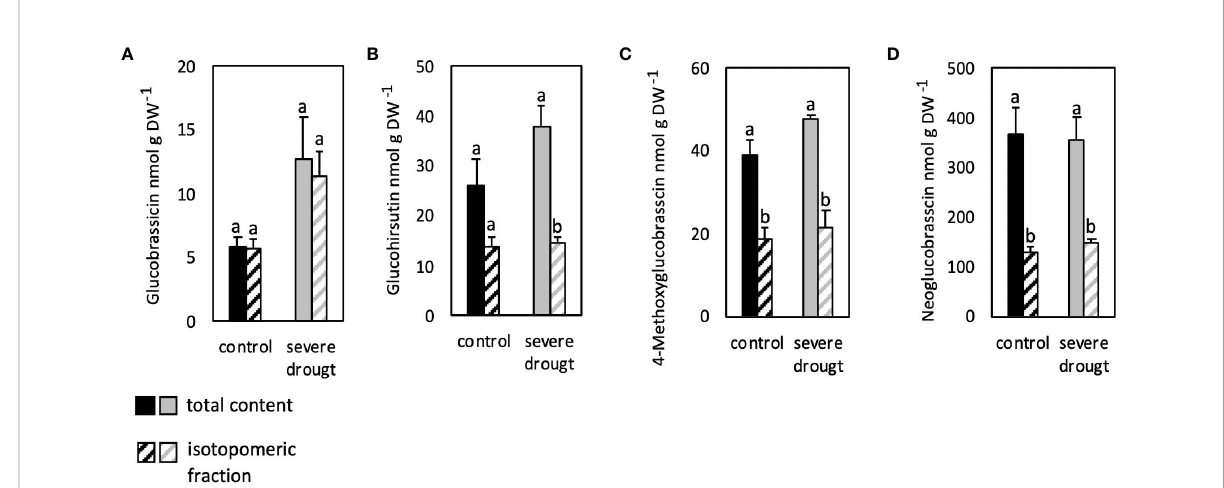
FIGURE 4 Isotopomeric and total contents of aliphatic (B) and indolic glucosinolates (A, C, D) in roots of severely drought-stressed Arabidopsis thaliana Col-0 plants subjected to 40% PEG 20,000 and 30% D 2 O for seven days. Plants were grown on petri dishes for fi ve weeks prior to application of severe drought stress (40% PEG 20,000). Bars represent means of three biological replicates consisting of four pooled plants each. Different letters indicate signi fi cant differences (p<0.05) between total glucosinolate contents and isotopomeric